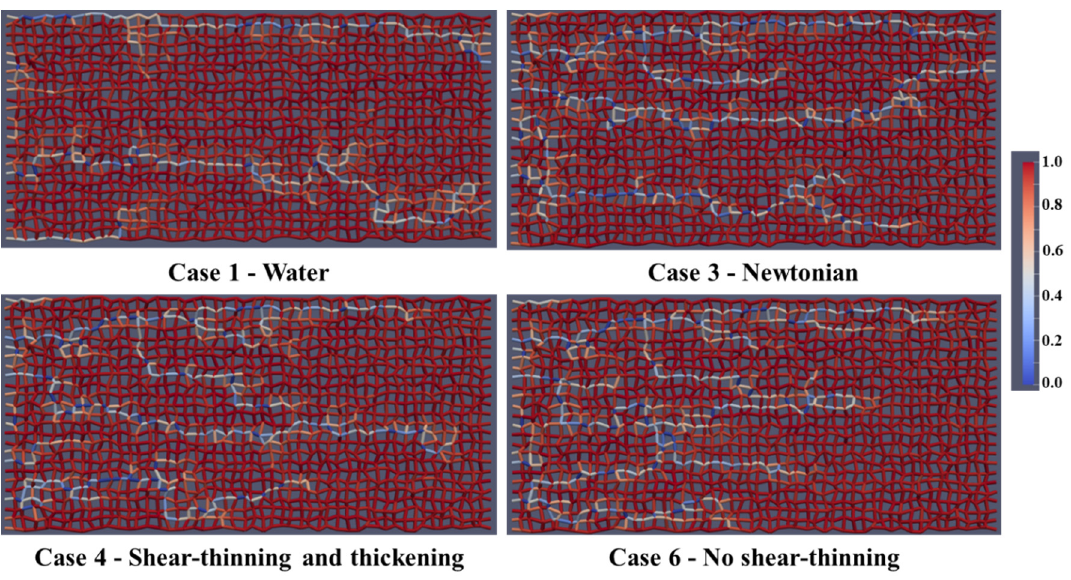
Figure 15. Fluid distribution (oil and water) after 0.1 PV of injected fluid with Q = 1 × 10 − 13 m 3 /s.